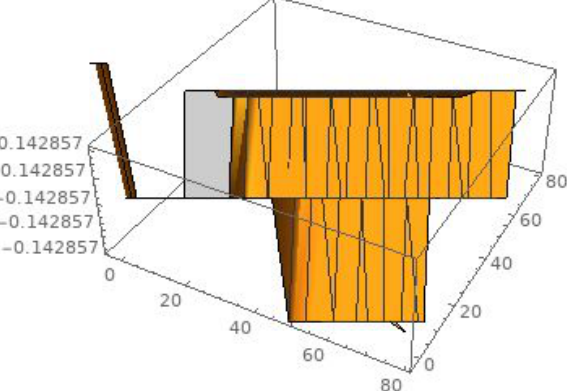
Fig. 1 3D-plot for | v ( x , y , t ) | 2 when y = 0 where µ = − 1, λ = 1, γ solution)